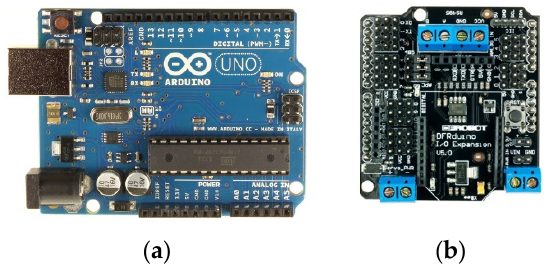
Figure 4. ( a ) Arduino UNO; ( b ) DFRduino I/O expansion board.